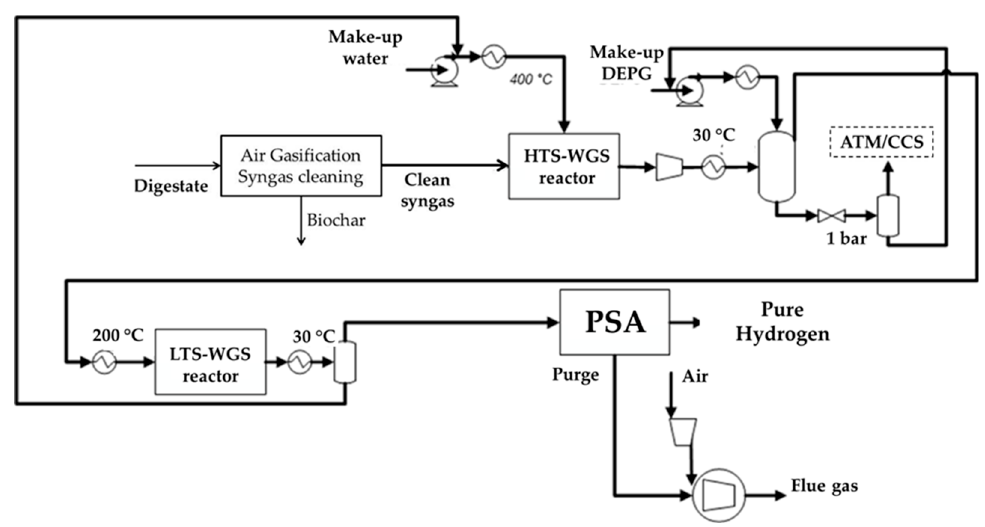
Figure 4. Flowsheet of valorization of digestate for producing hydrogen.